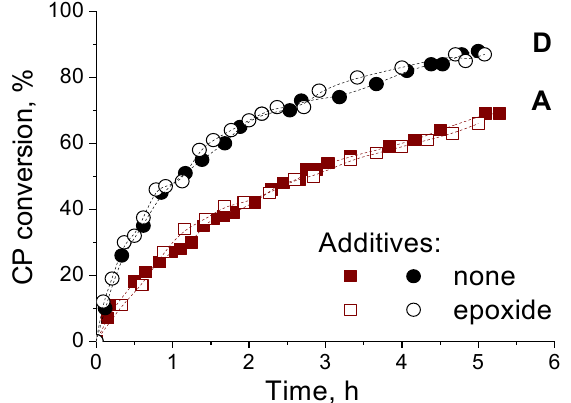
Figure 13. Effect of reaction products on CP oxidation with H 2 O 2 over Zr-MMM-E (samples A and D ). Reaction conditions: CP 0.1 mmol, catalyst 20 mg (0.005 mmol Zr), H 2 O 2 (30% aq.) 0.2 mmol, CH 3 CN 1 mL, 50 ◦ C. Additive: 0.02 mmol of CP epoxide (added in the beginning of the